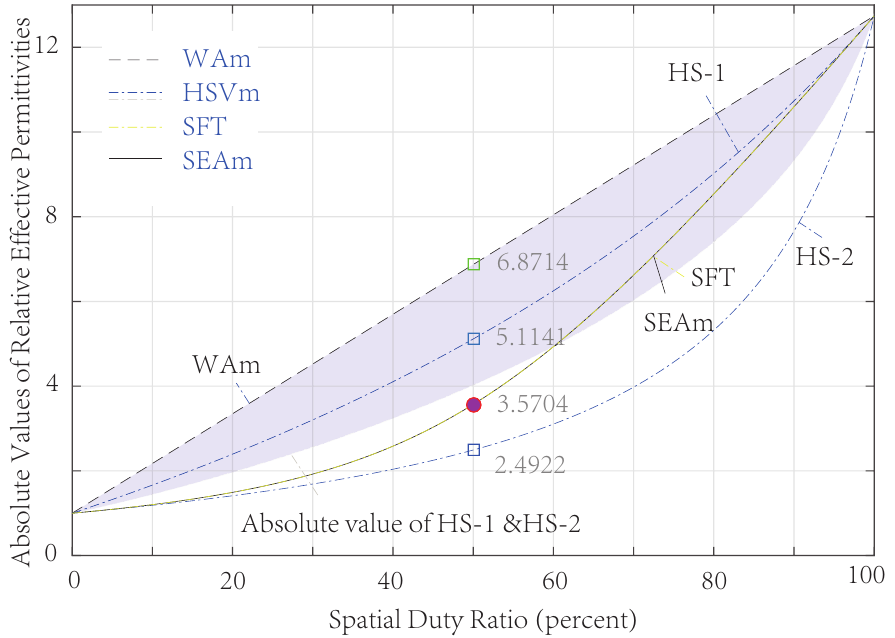
Figure 4. Absolute values of effective relative permittivities with dependencies on spatial duty ratio and material relative permittivities by various formulas to express a wave-absorbing honeycomb- structured cross-section. Round dot and squared dot symbols are highlighted for different approaches by same duty ratio of 50%. Shaded area is surrounded by two curves for WAm and square root values of two results by HSVm.